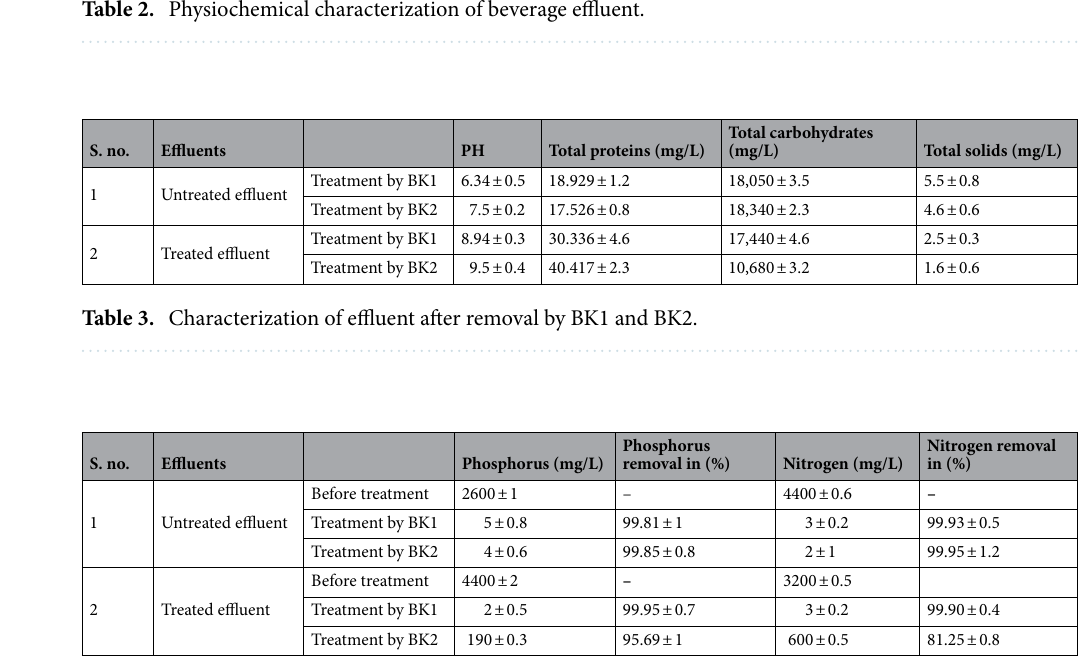
Table 4. Removal of nitrogen and phosphorus by strains BK1 and